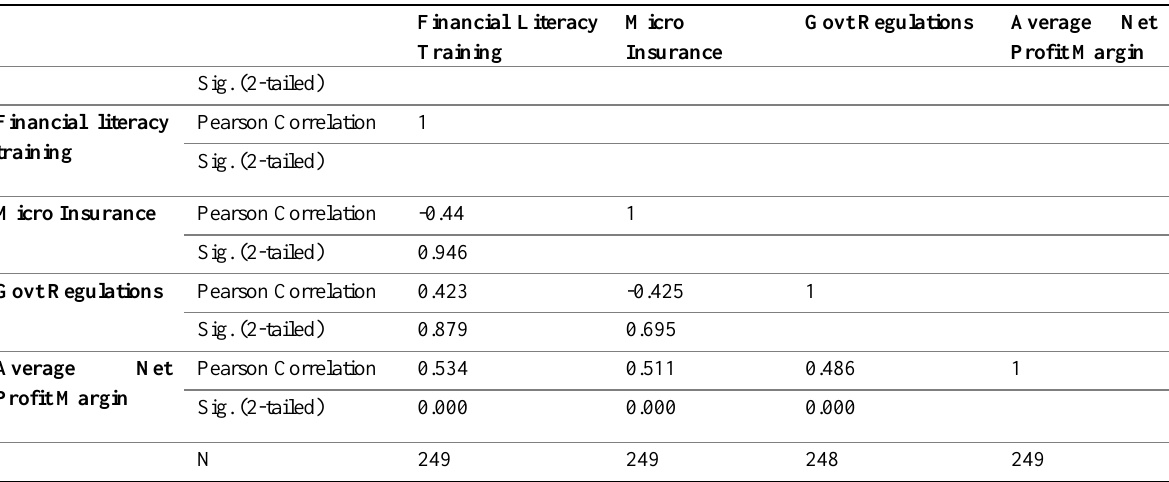
Table 2: Correlation Matrix for Linearity Testing